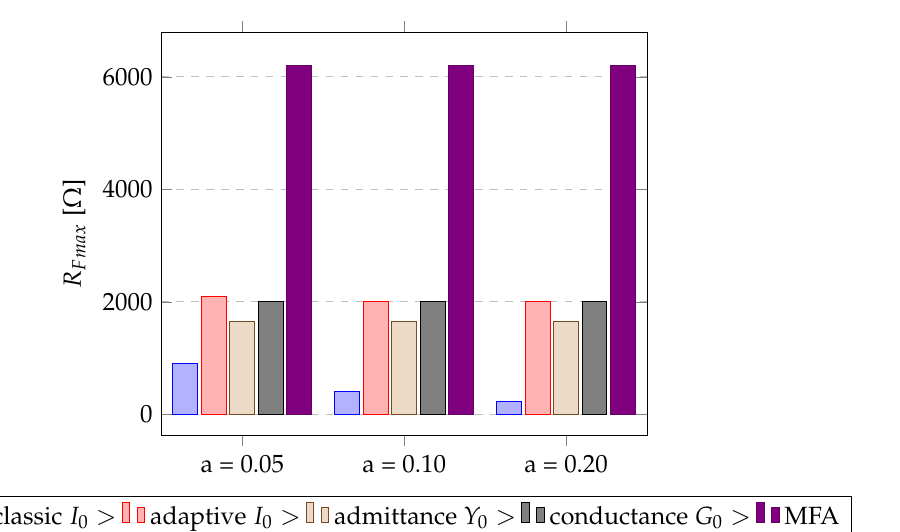
Figure 11. Maximum values of the detected transition resistance R Fmax in the modeled network assuming different earth fault